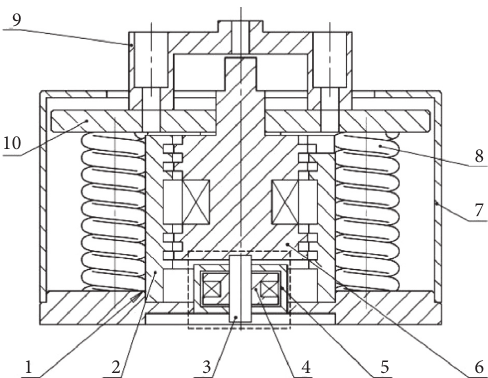
Figure 1: Structure of the proposed quasi-zero-stiffness vibration isolator: ① base; ② stator; ③ intermediate shaft; ④ valve body; ⑤ shell; ⑥ rotor ⑦ casing; ⑧ supporting spring; ⑨ support; ⑩ supporting